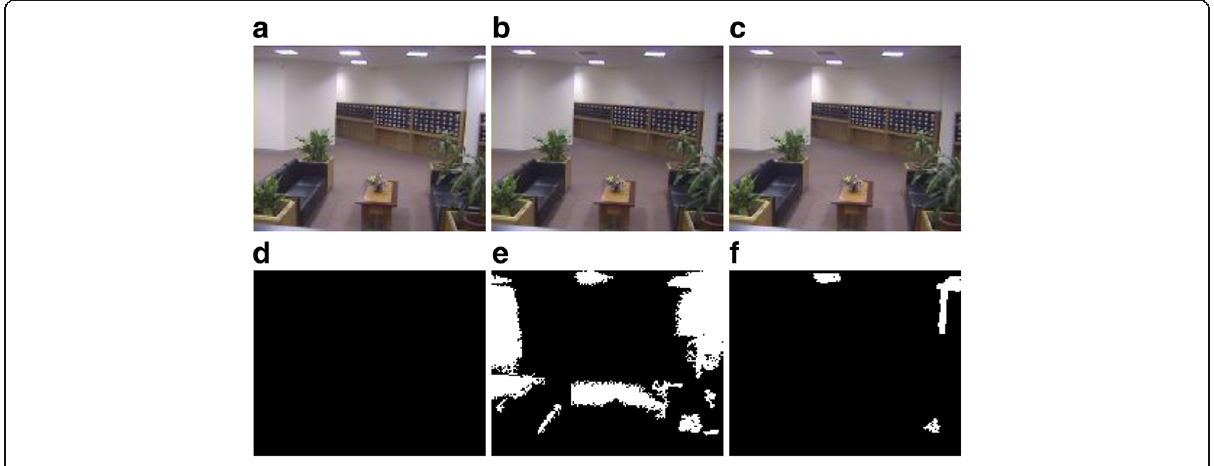
Fig. 8 Short-term background model update. a – c Original image frames 124, 126, and 128. d – f Segmented results